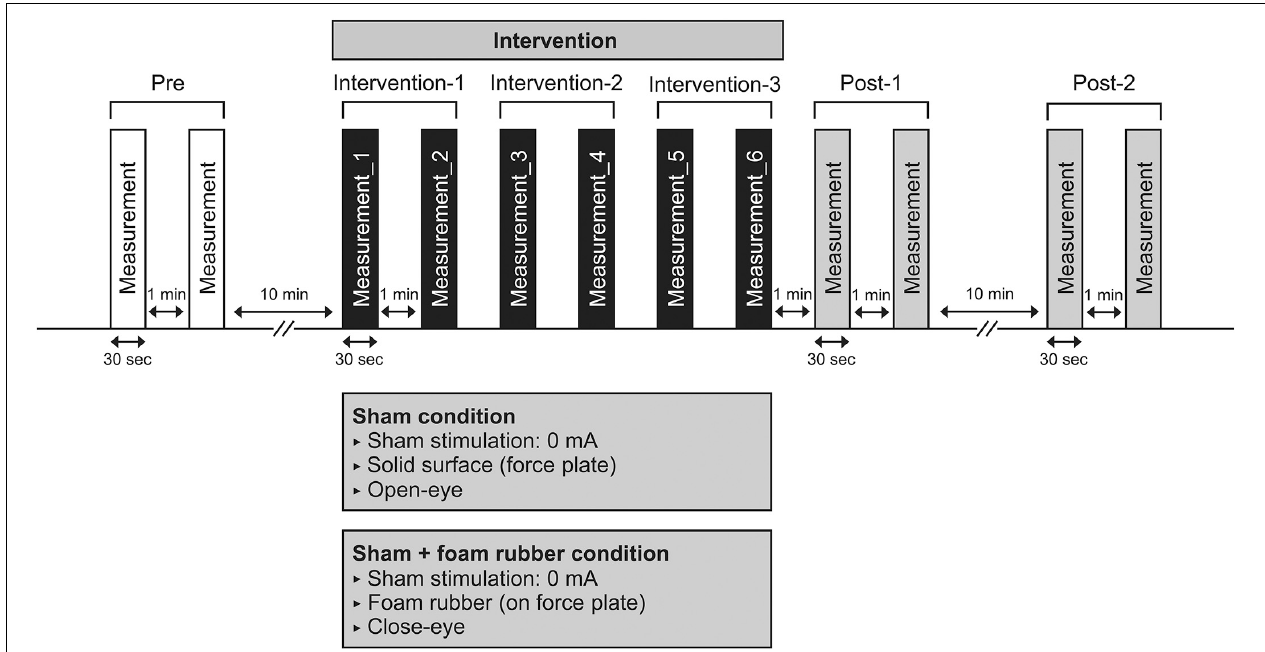
FIGURE 2 | Experimental 2 procedure. Participants underwent COP sway measurements during the intervention six times after COP sway measurements in pre. COP sway measurements at post-1 were performed immediately after the intervention, and a further COP sway measurement (post-2) was performed 10 min after. TABLE 1 | The results of two-way repeated measures ANOVA for Experiments 1 and 2. Intervention Time Intervention × Time F -value P -value F -value P -value F -value P